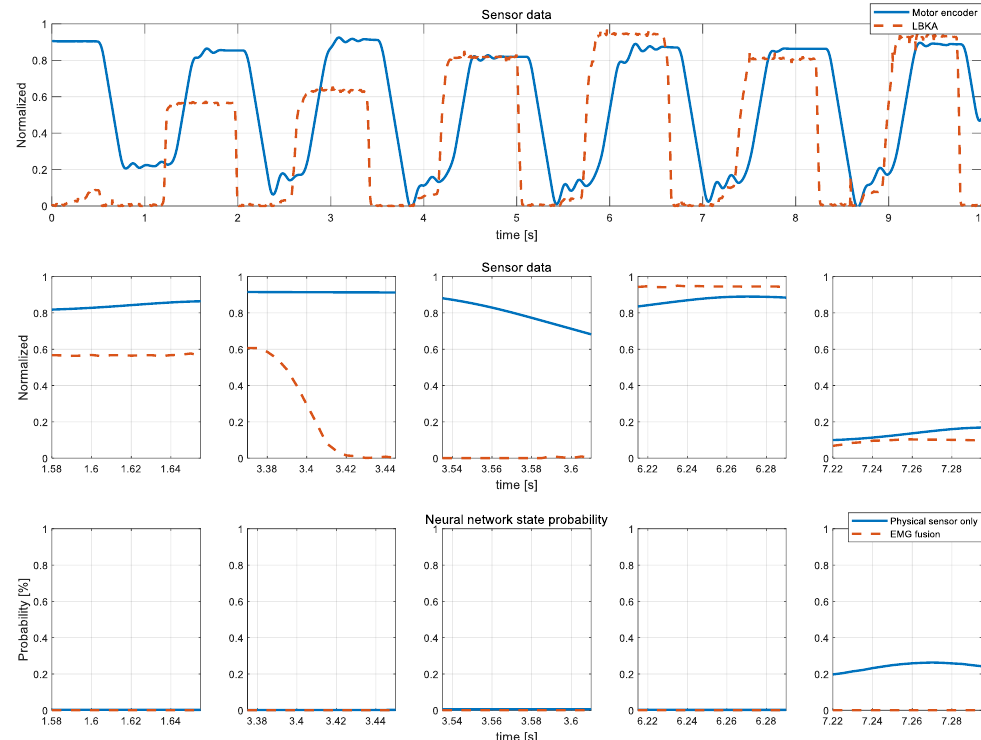
Figure 14. Detailed view of various cases of exception state and probability of each case.